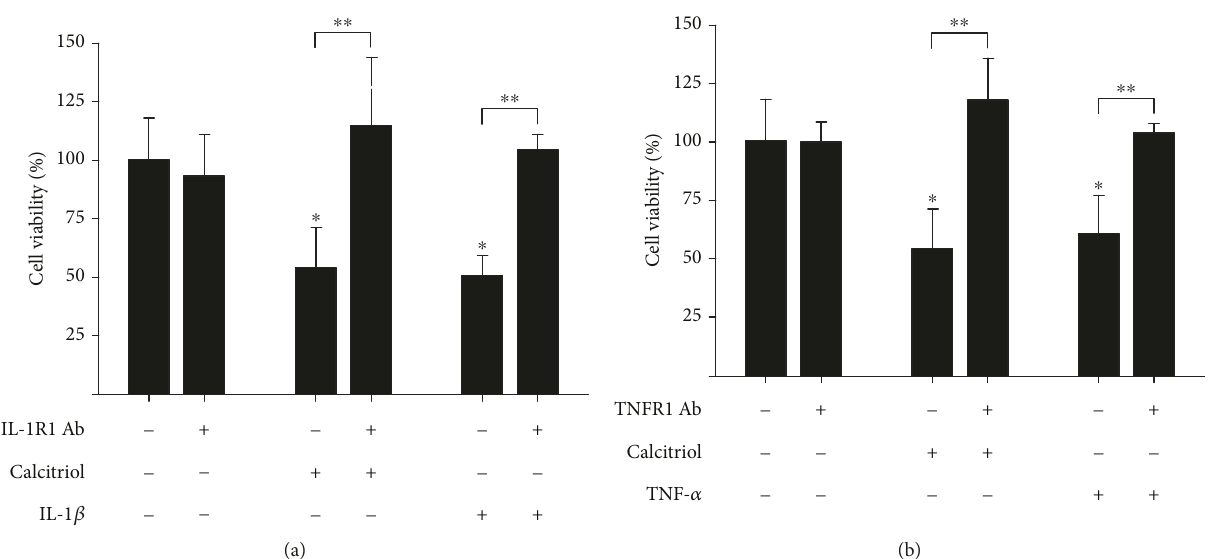
Figure 5: Calcitriol inhibited cell proliferation by inducing endogenous production of IL-1 β and TNF- α . SUM-229PE cells were treated with calcitriol (10 nM), IL-1 β (0.5ng/ml), TNF- α (5 ng/ml), anti-IL-1R1 (5 ng/ml), and anti-TNFR1 (2 ng/ml), individually or combined as indicated. Cell proliferation was evaluated after 6 days of treatment using the XTT method. Vehicle-treated cells were considered as 100% of cell proliferation. The results represent the average of 3 experiments, each in triplicate ± SD . ∗ P < 0 05 vs. vehicle-treated cells (-). ∗∗ P < 0 05 calcitriol or cytokine alone vs. combined